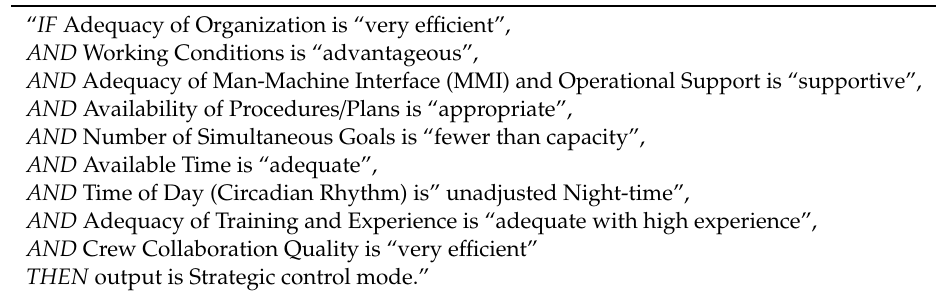
Table 3. Example of fuzzy inference